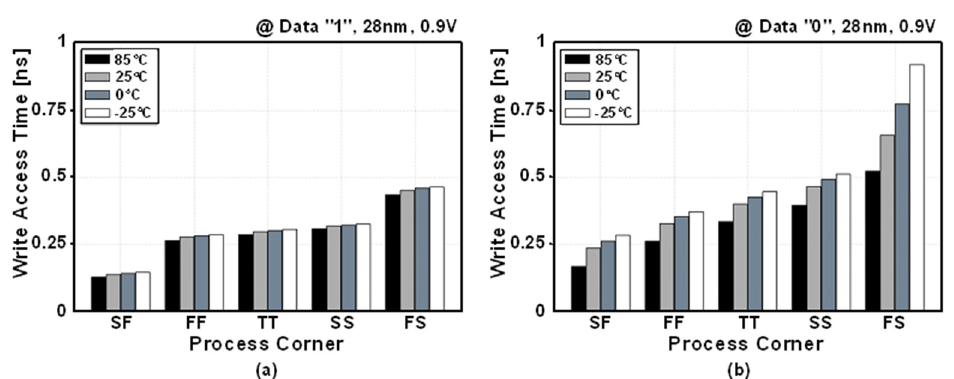
Figure 13. Post-layout simulated write-access times when storing data ( a ) “0” and ( b ) “1” across five process corners and four temperature cases.